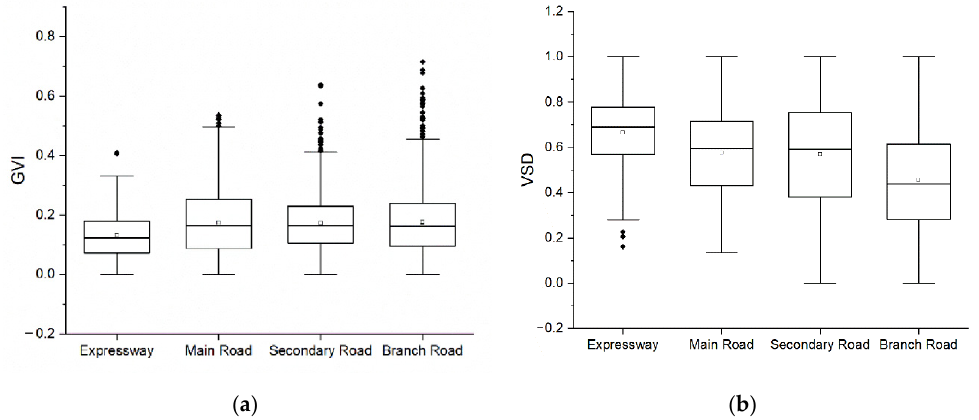
Figure 15. GVI and VSD distributions of different road levels in box plots. ( a ) Box plots of GVI distribution. ( b ) Box plots of VSD distribution.